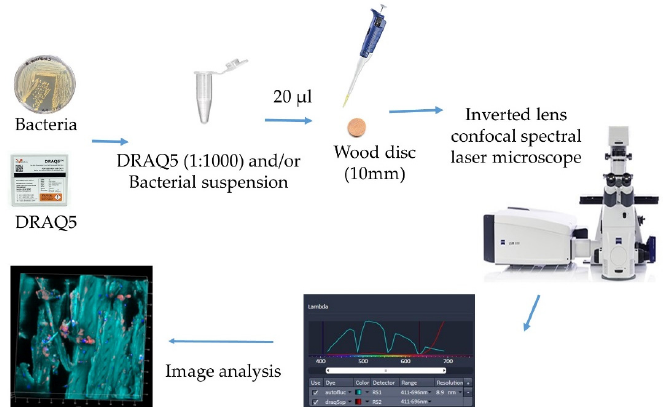
Figure 6. Methodology to observe DRAQ5-labeled bacteria with confocal spectral laser microscopy [adapted from Dubreil et al. [42]]. 3.2. Methods to Study the Antimicrobial Properties of Wood Extractives